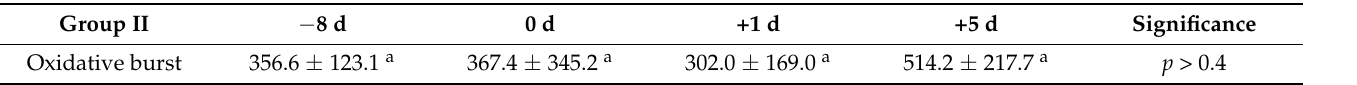
+5 d. Statistical difference according to the Tukey–Kramer test—Beltsville,